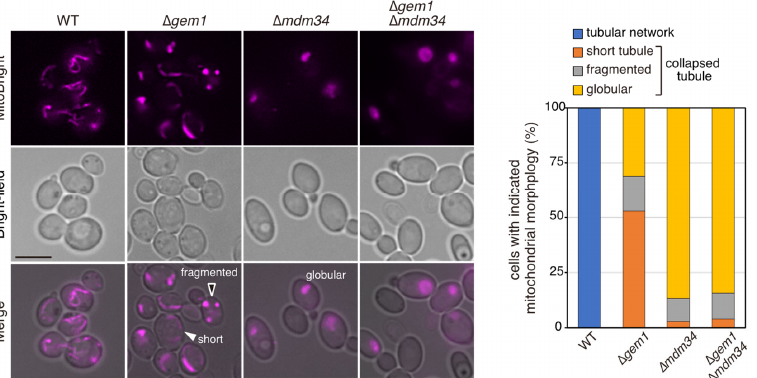
Figure 2. Mitochondrial morphology in ∆ gem1 and ∆ mdm34 cells. Exponentially growing cells were incubated at 37 °C in minimum SD medium, stained with MitoBright LT Red, and observed by fluorescence microscopy. The percentage of cells with the indicated mitochondrial morphology for each strain is shown in the bar graph ( n = 200). Scale bar, 5 μ m.